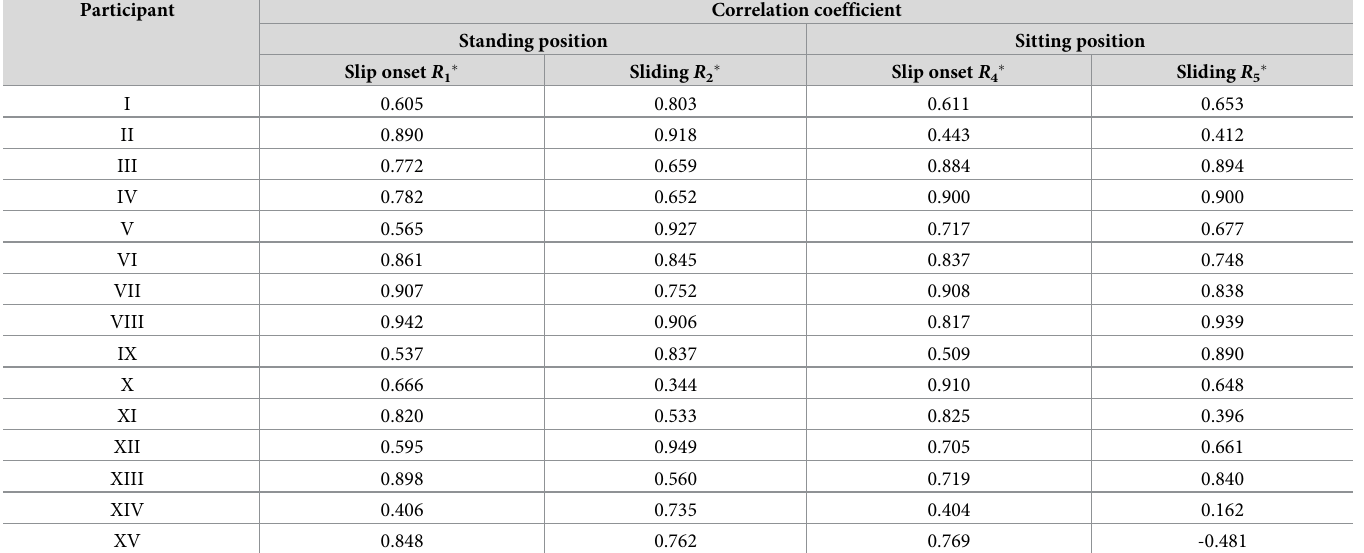
Table 2. Correlation coefficients for each participant after